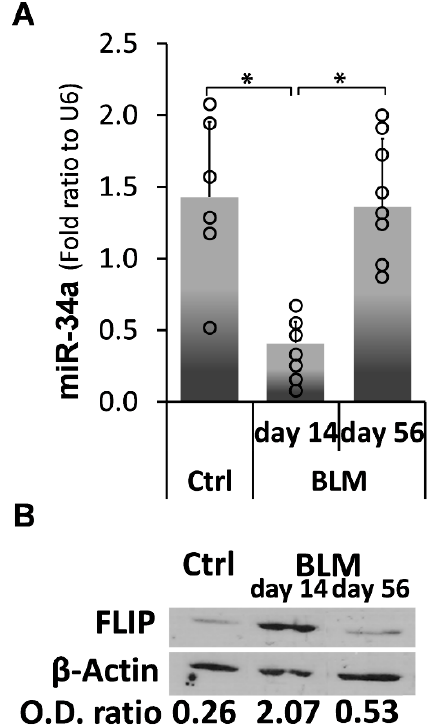
Figure 4. Kinetics profile of miR ‐ 34a, in Bleomycin ‐ treated mice shows reduction at times of fibrosis evolution and upsurge to normal levels at resolution, and an inverse correlation with FLIP. C57BL / 6 wild ‐ type mice were exposed to Bleomycin (0.03 mU/mice) or control ‐ saline, sacrificed 14, 56 days post Bleomycin ‐ OA, and myofibroblasts were isolated. ( A ) Total RNA was extracted and qPCR miR ‐ 34a expression levels determined (calculated as 2 −∆∆ Ct ). ( B ) Myofibroblast cell lysates were obtained to assess FLIP in Wb using anti ‐ FLIP mAb. OD ratios, normalized to β‐ actin at each time point, are presented. One representative of four experiments with similar results; n = 5–6 for each time point; error bars represent mean ±SD; circles represent individual data points. * p < 0.001.